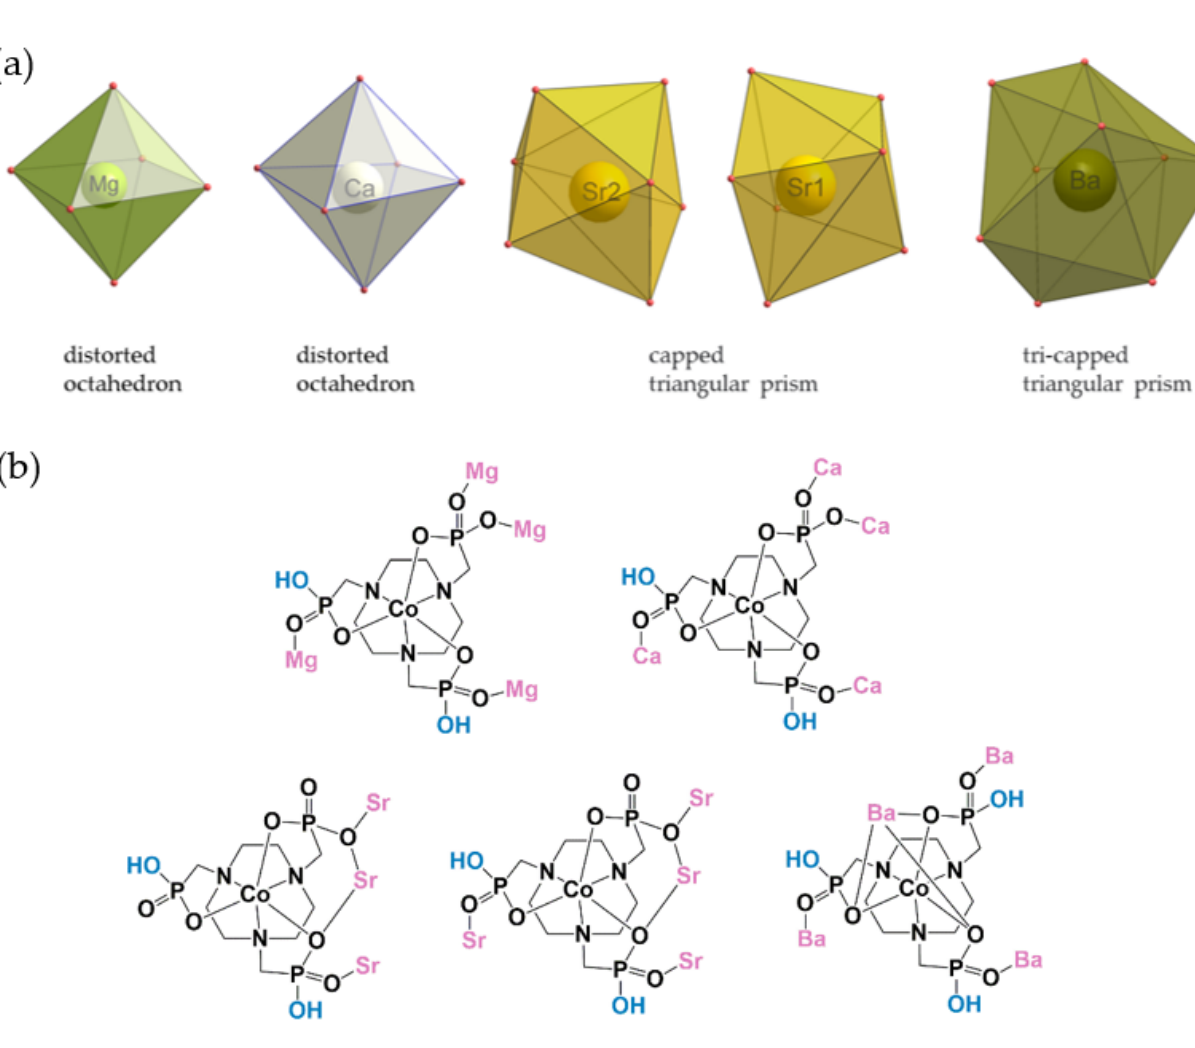
Figure 7. Diversities of coordination geometry ( a ) at the Mg(II), Ca(II), Sr(II), and Ba(II) centers, and coordination modes ( b ) in the tripodal metalloligand Co(notpH 2 ) − .